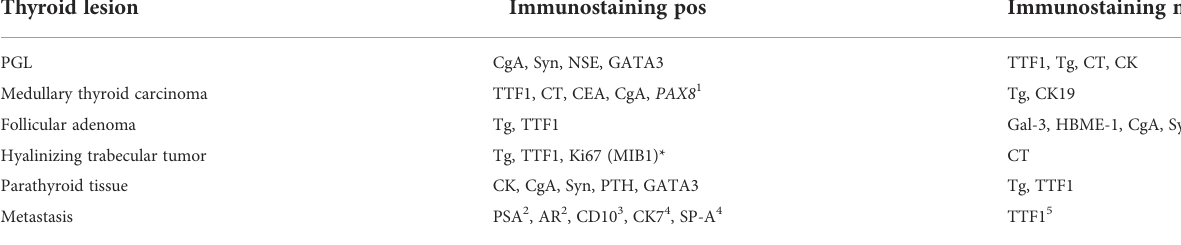
TABLE 1 Differential diagnosis of intrathyroidal PGL with the other lesions by immunohistochemistry.